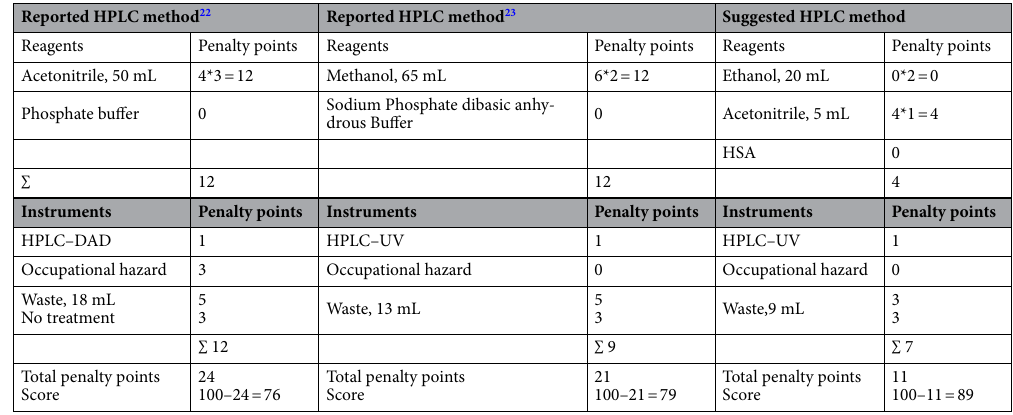
Table 10. Eco-scale penalty points for the reported and the proposed HPLC